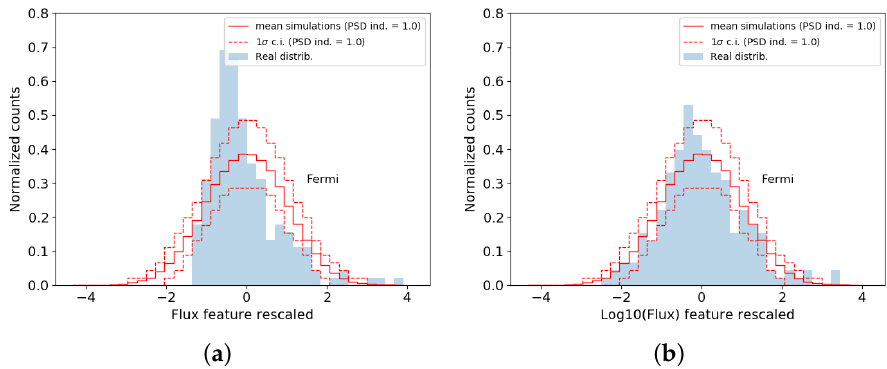
Figure 1. Figure shows the histogram of the observed Fermi-LAT lightcurves compared to those for simulations. Using simulations confidence intervals (dashed red) are derived at the 1 σ level for each bin. ( a ) Simulations of the fluxes that are normally distributed. ( b ) Simulations of the logarithm of fluxes that are normally distributed or lognormal simulations. The lognormal simulations fit the lightcurves significantly better with SW p -values of 0.013 relative to 1.78 × 10 − 14 or p (cid:28) 0.001 for the normal